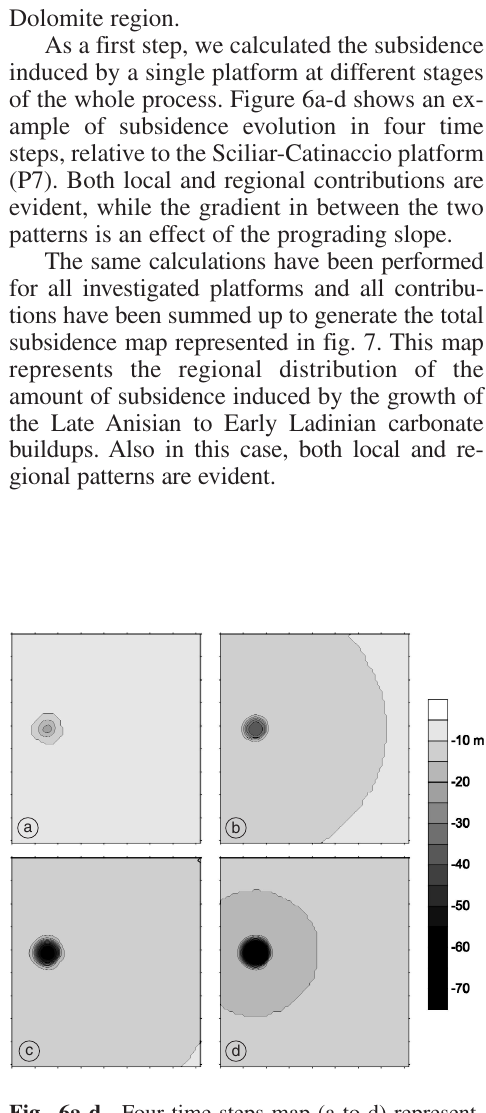
Fig. 6a-d. Four time-steps map (a to d) represent- ing the progressive subsidence induced by the growth of a single pre-volcanic platform: the exam- ple corresponds to the Sciliar-Catinaccio (P7 in figs. 4 and 5 and in table II). The contour lines of the in- duced subsidence are in meters (see grey scale).